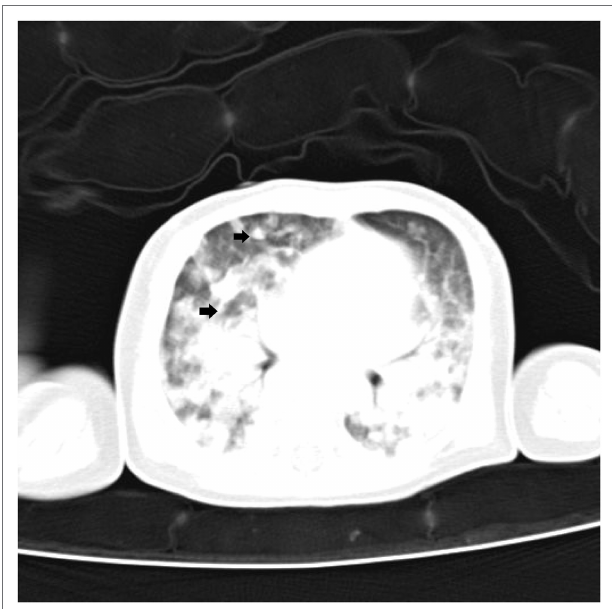
FIGURE 1 | Chest computed tomography image of patient 1 showing many miliary nodules (arrowheads) can be seen in both lungs.